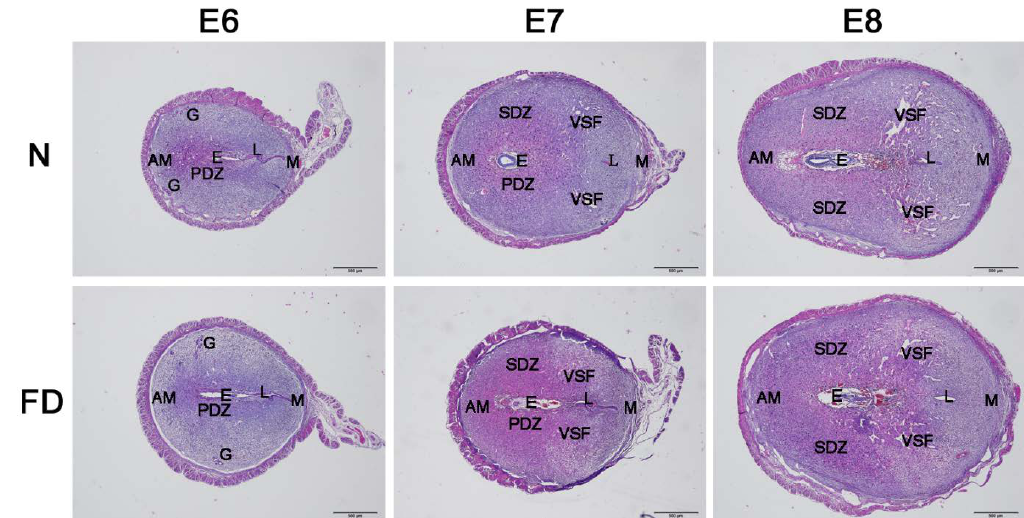
Figure 1. Uterine section’s hematoxylin-eosin staining from E6 to E8. No significant abnormal decidualization or embryonic development occurred in the folate-deficient group.